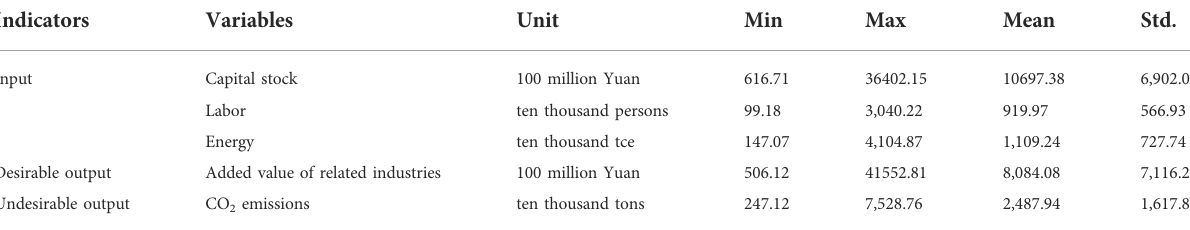
TABLE 1 Descriptive statistics of Input-Output